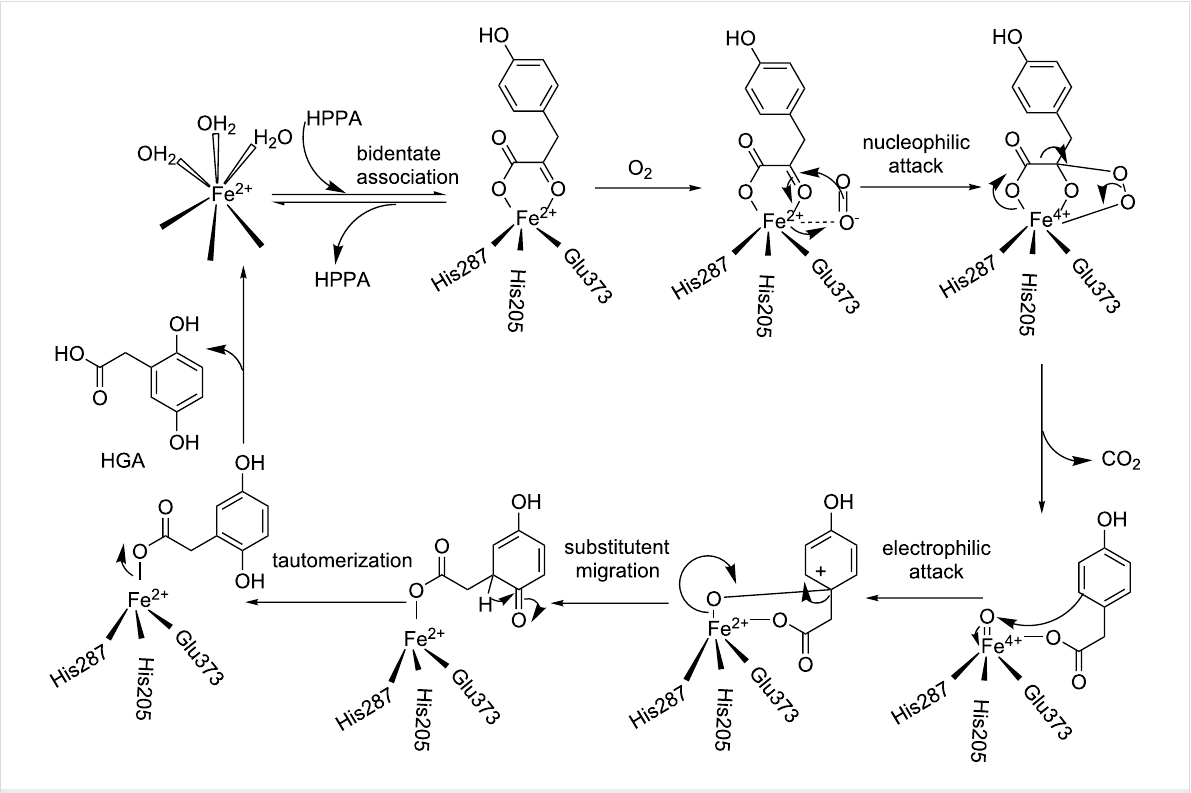
Scheme 1: The commonly recognized HPPD catalytic reaction